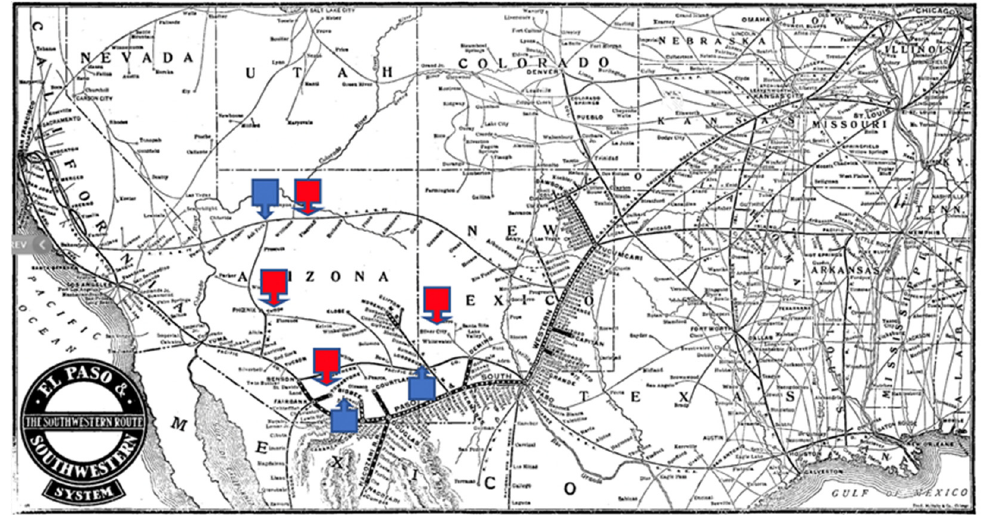
Figure 18. Red flags denote the distribution of the “pinwheel” motif along the southwestern RR corridors. Blue flags denote additional WMP sites located along these corridors.